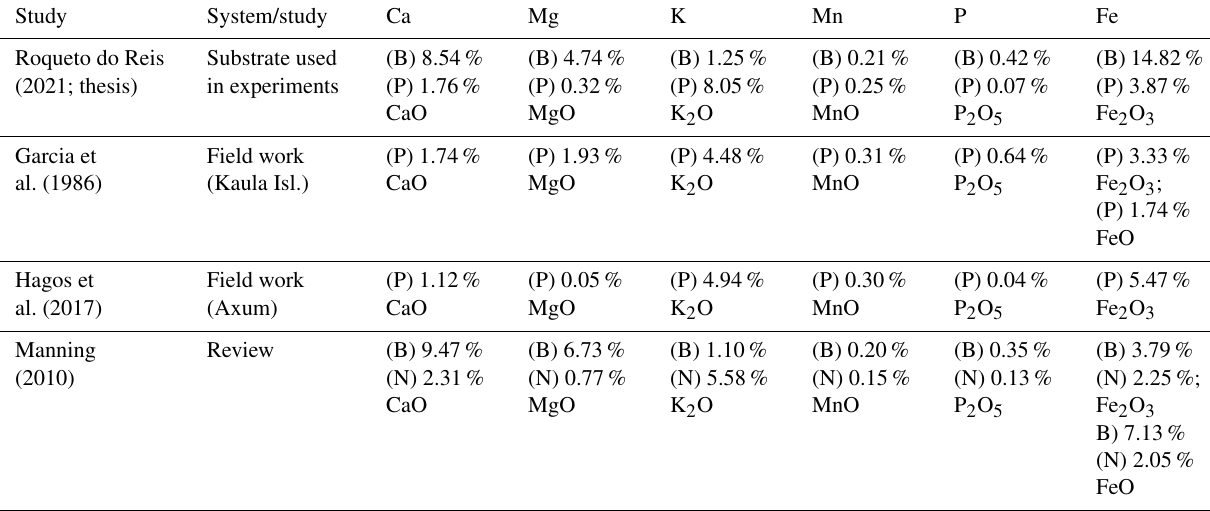
Table A1. References of selected chemical components of basaltic and phonolitic substrates. (B) indicates basaltic, (P) phonolitic, and (N) nepheline syenite (phonolite equivalent with larger grain size) substrates or treatments.